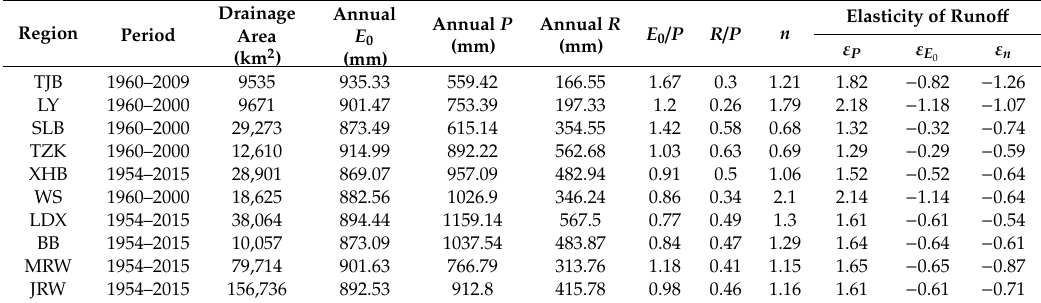
Figure 4. Spatial distribution of the annual aridity index and elasticity value. Table 2. Hydrometeorological characteristics of sub-regions in the Jialing River Basin.